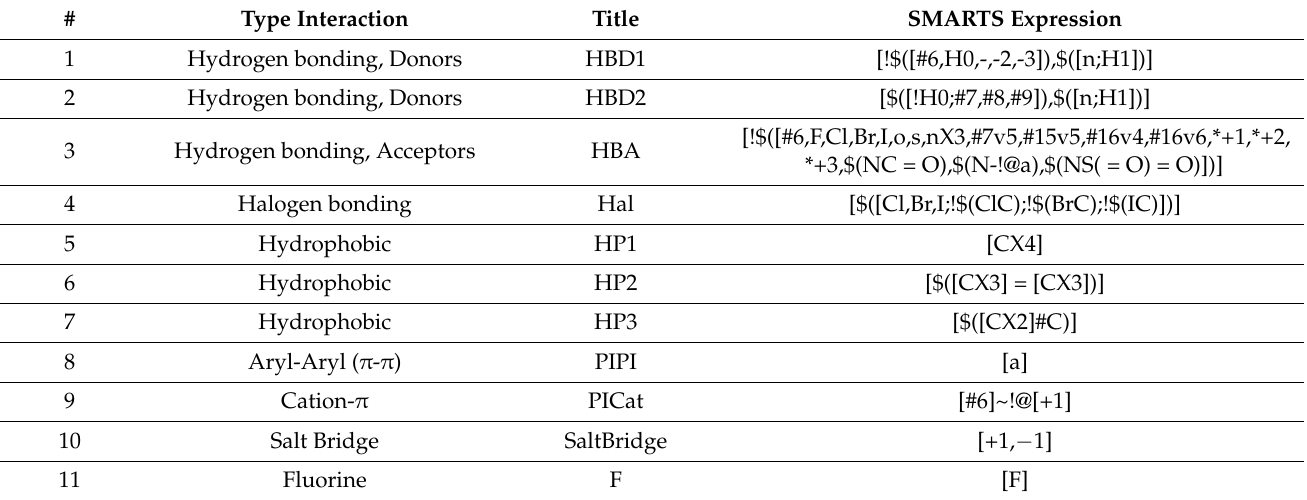
Table 11. Fragment types describing intermolecular interactions expressed using